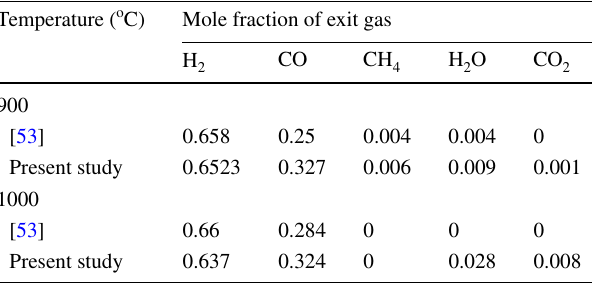
Table 1 Comparison of thermodynamic results with results reported by Warren et al. [53] for the reduction of ceria with methane